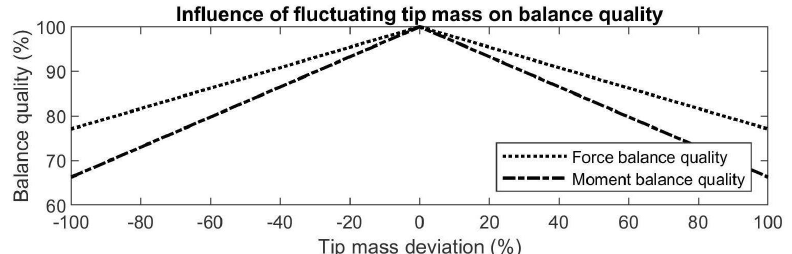
Figure 10. The influence of the tip mass on the balance quality shows to be